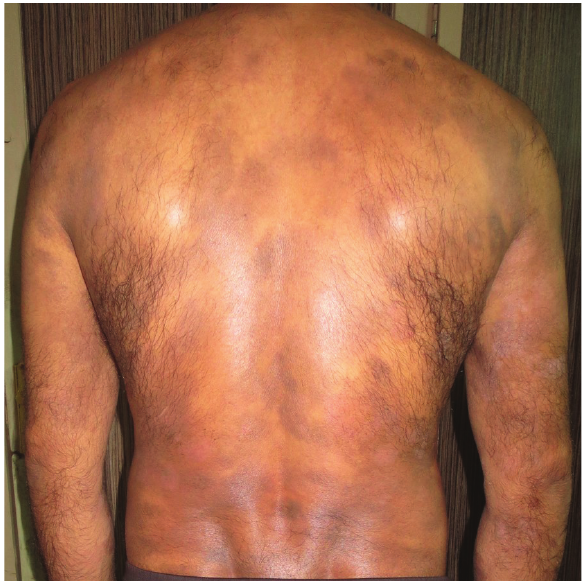
Figure 1. Mycosis fungoides in a 40-year-old man manifested as generalized atrophic patches.